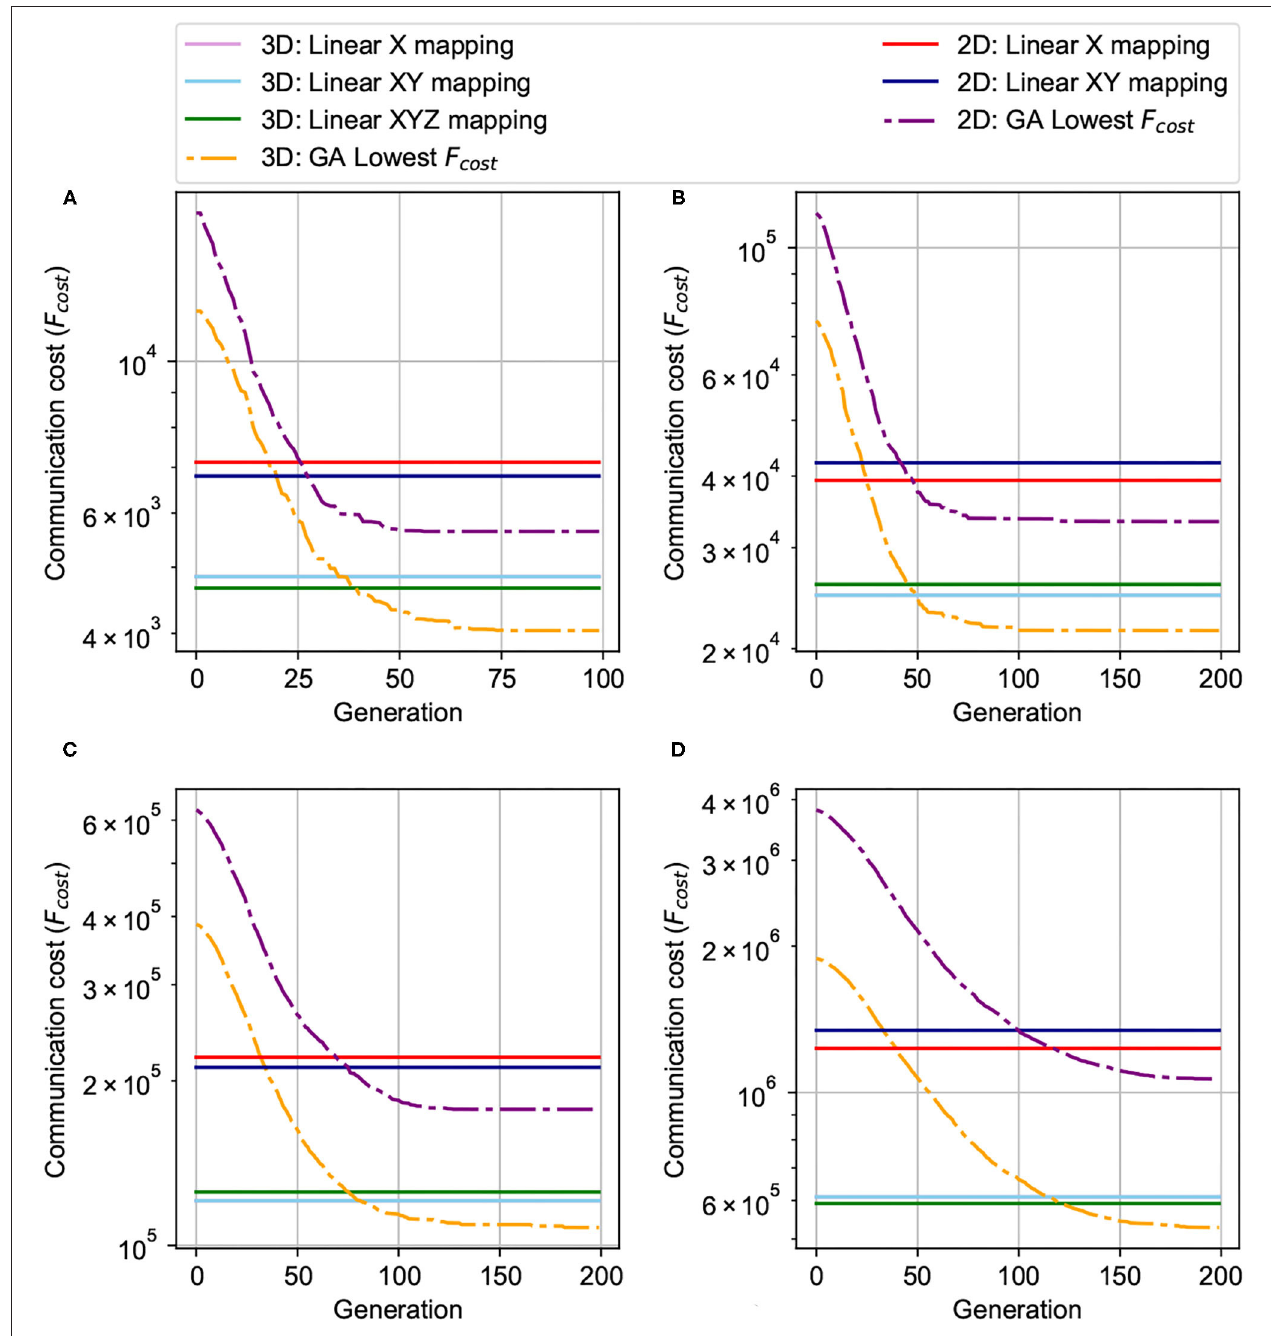
FIGURE 14 | Comparison between 3D and 2D mapping. (A) 64 nodes (4 × 4 × 4 and 8 × 8) NoC-based, 256 neurons/node. (B) 128 nodes (4 × 4 × 8 and 8 × 16) NoC-based, 256 neurons/node. (C) 256 nodes (4 × 8 × 8 and 16 × 16) NoC-based, 256 neurons/node. (D) 512 nodes (8 × 8 × 8 and 16 × 32) NoC-based, 256